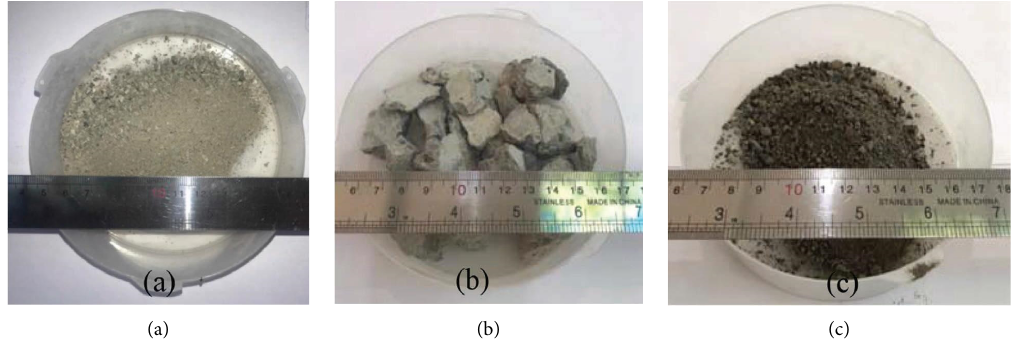
Figure 2: Te materials used (a) fne serpentine aggregates, (b) coarse serpentine aggregates, and (c) lead